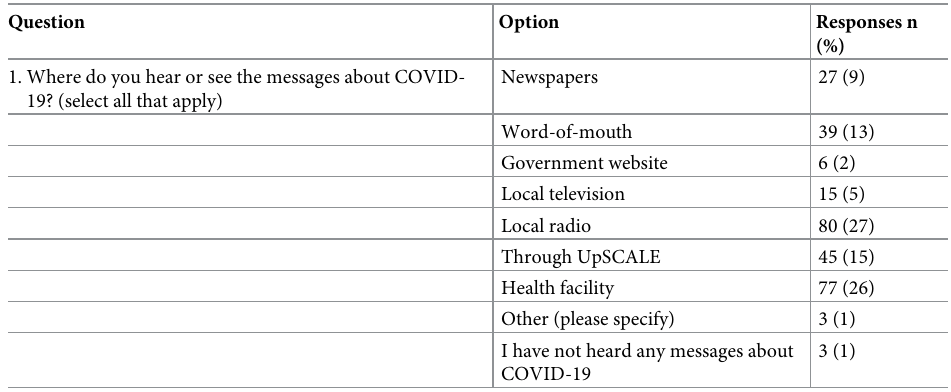
Table 2. Participants sources of knowledge of COVID-19 (N =